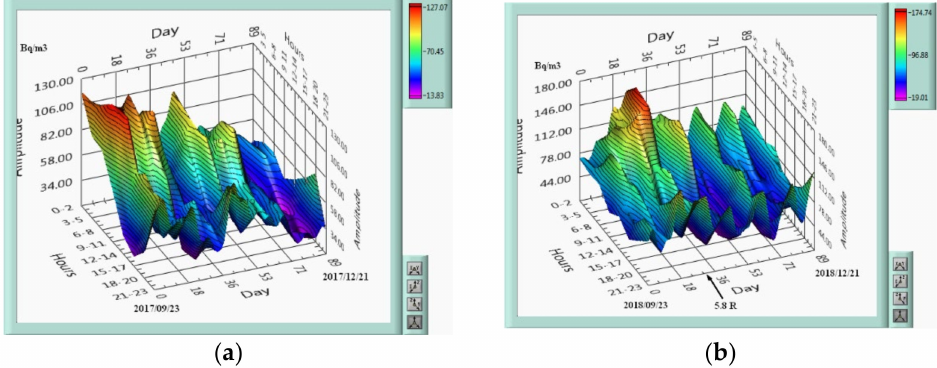
Figure 6. Radon evolution in Bisoca station, autumn: ( a ) 2017; ( b ) 2018.